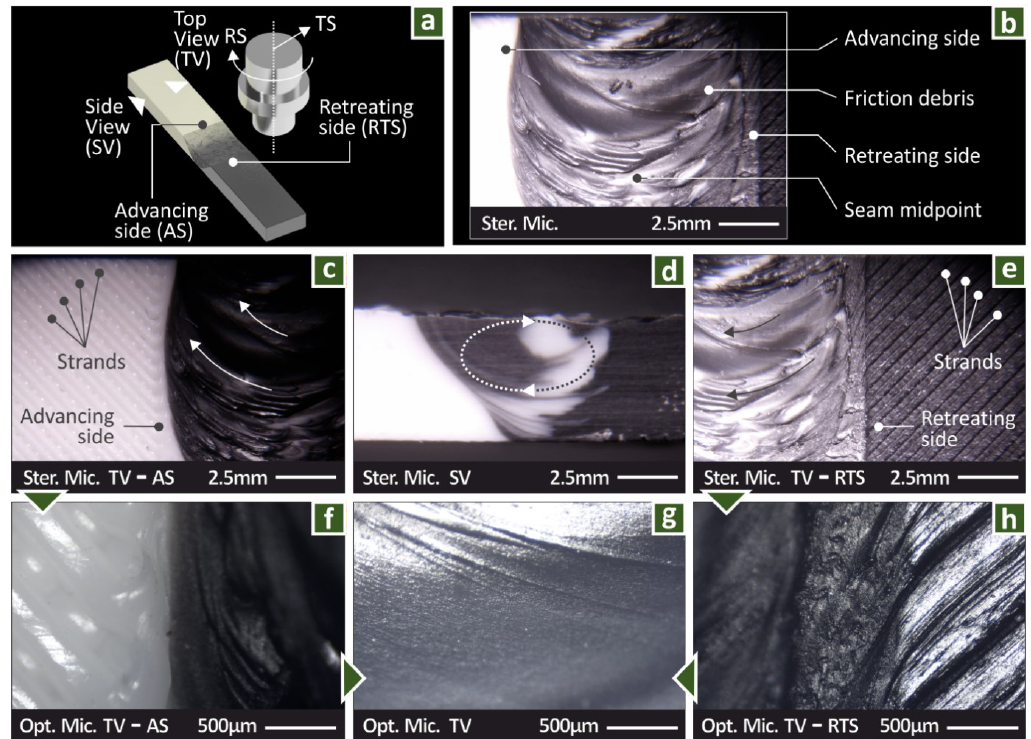
Figure 5. ( a ) The specimens’ different areas, ( b ) HAZ view, ( c ) advancing side view, ( d ) cross-section of the welding zone, ( e ) view of the retreating side, ( f ) advancing side view, ( g ) welding zone view, ( h ) retreating side view.